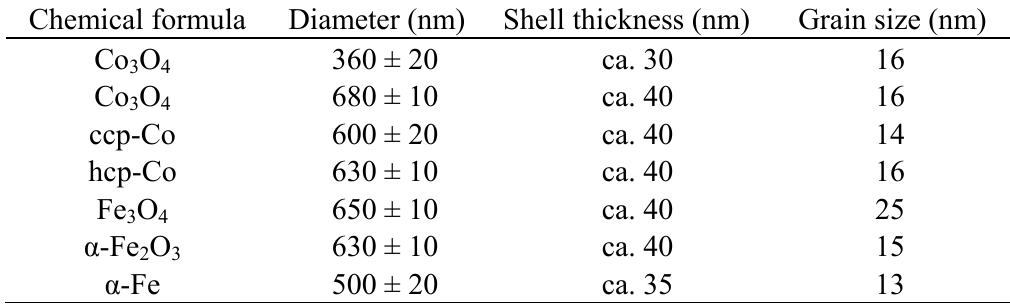
Table 1. Size parameters for the spherical hollow